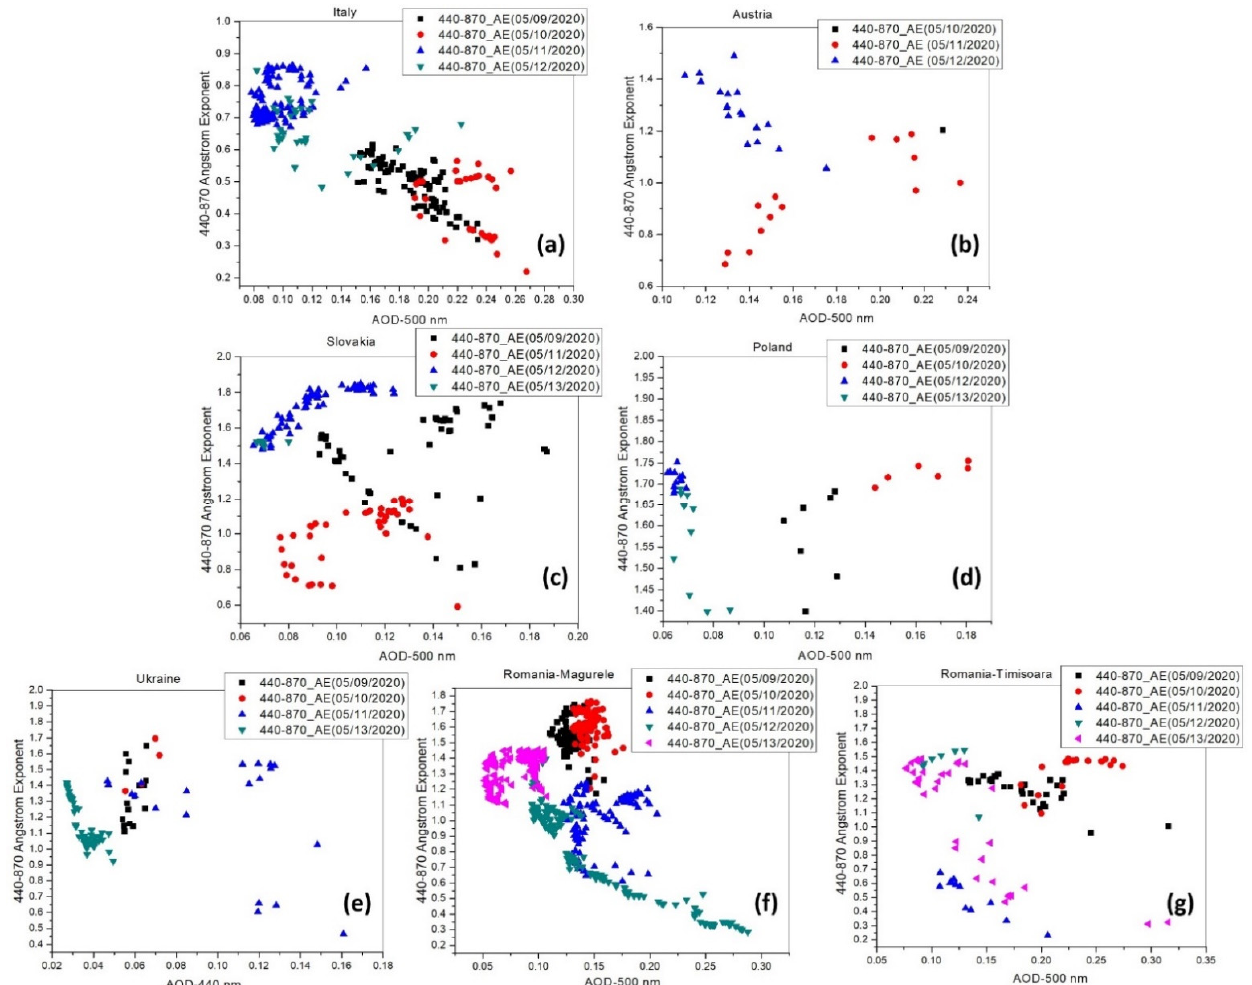
Figure 6. Evolution of AOD at 500 nm depending on Angstrom exponent at 440 ‒ 870 nm (9 ‒ 13 May 2020): ( a ) Rome–La Sapienza (level 2.0), ( b ) Austria-Vienna-Univie (level 1.5), ( c ) Slovakia-Poprad-Ganovce (level 2.0), ( d ) Poland-Strzyzow (level 1.5), ( e ) Ukraine-Kiev (level 1.5), ( f ) Romania-Magurele (level 2.0), and ( g ) Romania-Timisoara (level 2.0).